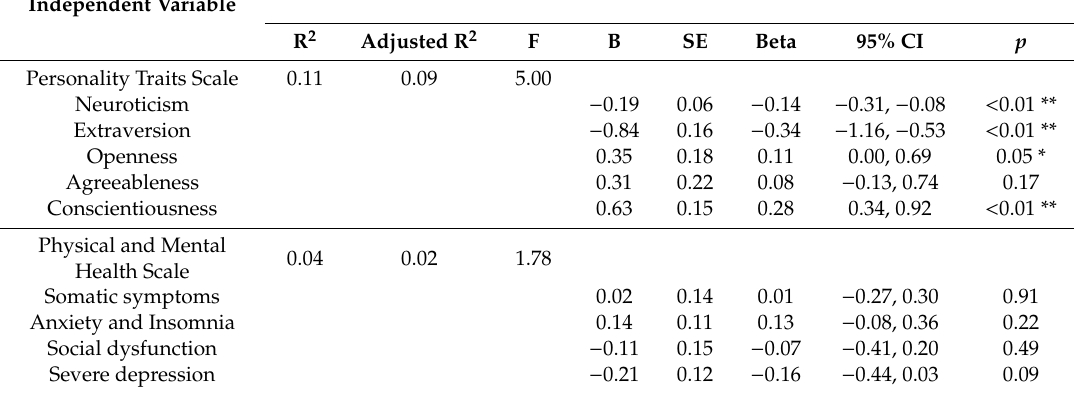
total score and the Personality Traits Scale, as well as the Physical and Mental Health